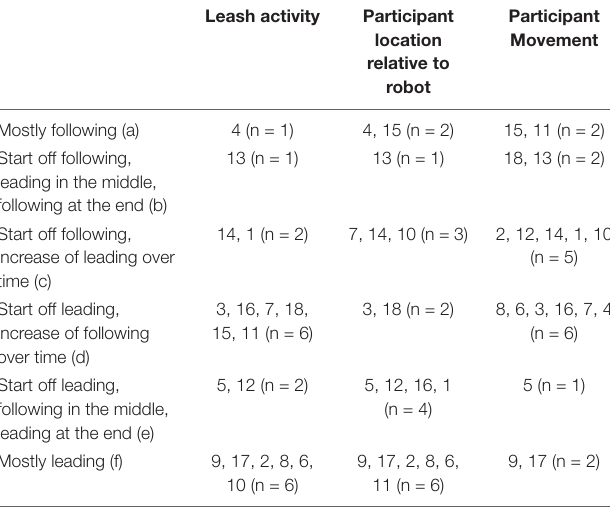
TABLE 5 | An overview of the distribution of participants across all six behavior development types for each behavior dimension (leash activity, participant location and participant